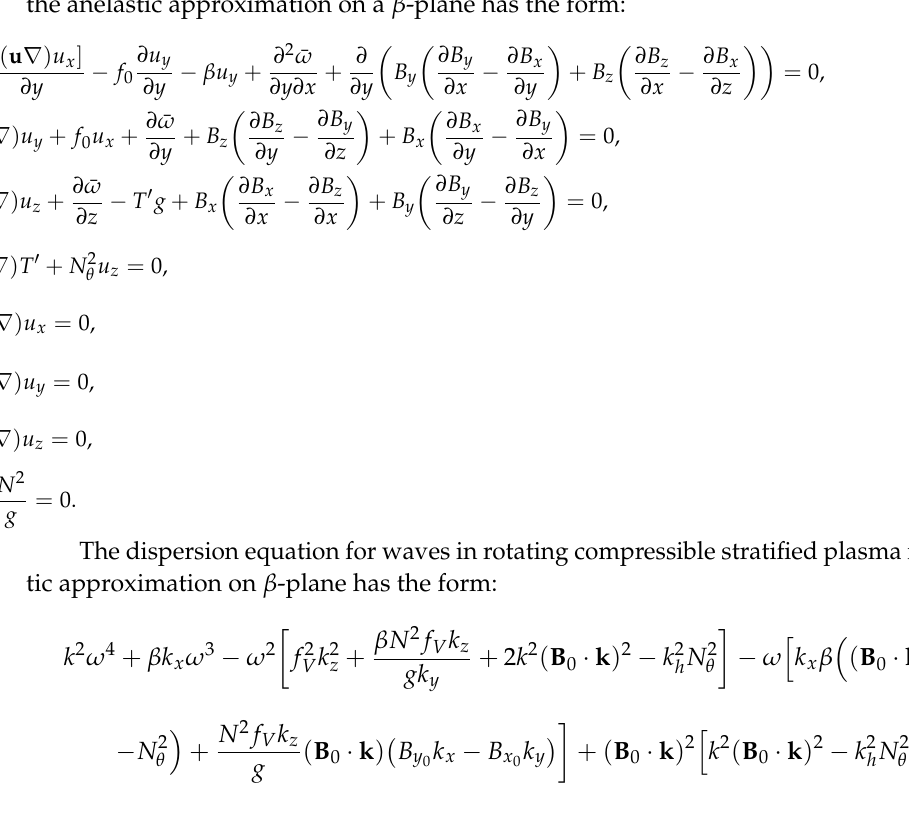
Figure 15. Dispersion curves for ( a ) 1—compressible magnetic inertia-gravity wave ω mig 2—compressible magnetostrophic wave ω mstr 2—Alfven wave ω A